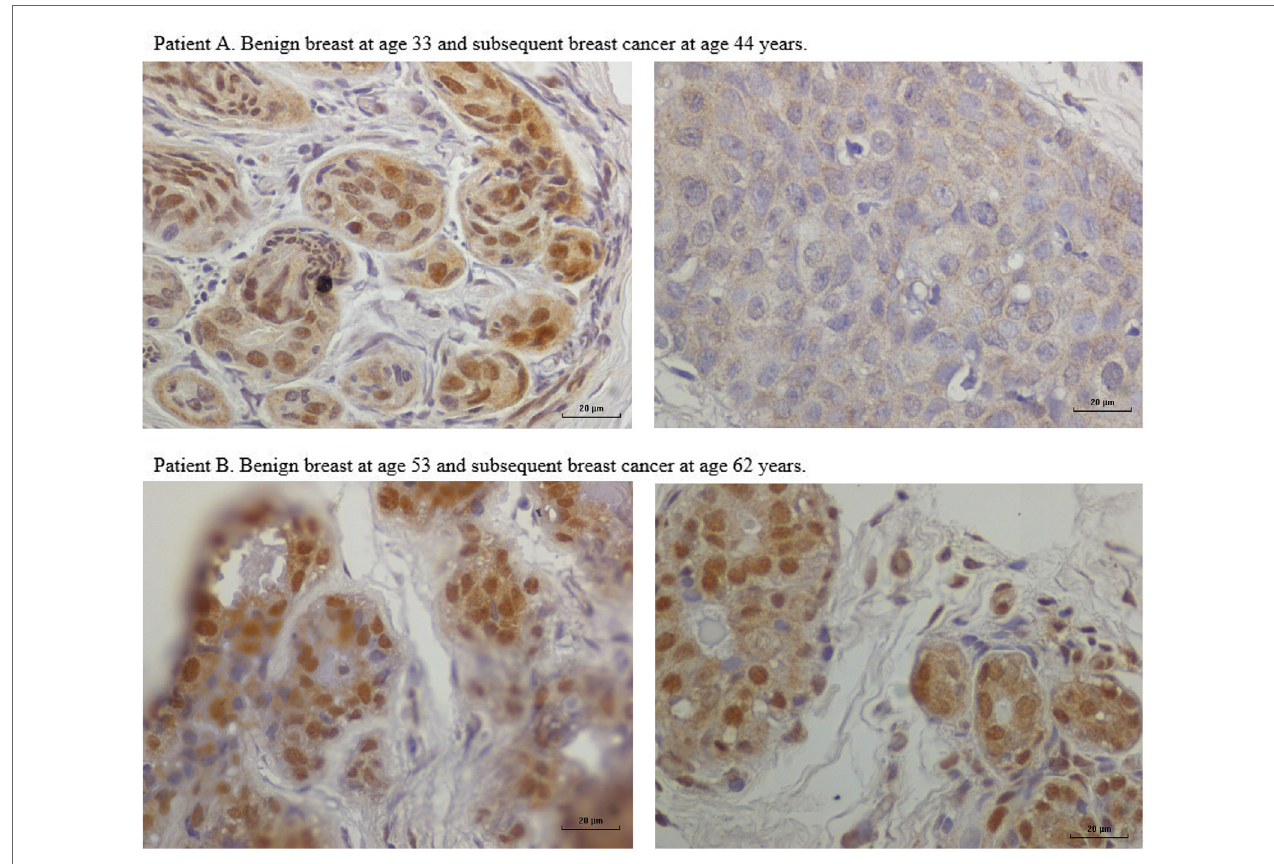
FigUre 4 | hPV e7 protein expression in hPV 18-positive benign and subsequent hPV 18-positive breast cancer demonstrated by immunohistochemistry . Patient A. Benign breast specimen from a patient at age 33 years and subsequent invasive breast cancer in the same patient aged 44 years. HPV E7 protein brown staining is positive, blue staining is negative. There is strong HPV E7 protein expression in the nuclei of benign specimen. There is no HPV E7 protein expression in the subsequent invasive breast cancer specimen from the same patient. These observations are compatible with HPV having a role early in breast oncogenesis. Patient B. Benign breast specimen from a patient at age 53 and subsequent breast cancer in the same patient aged 62 years. There is strong HPV E7 protein staining in both the benign and subsequent breast